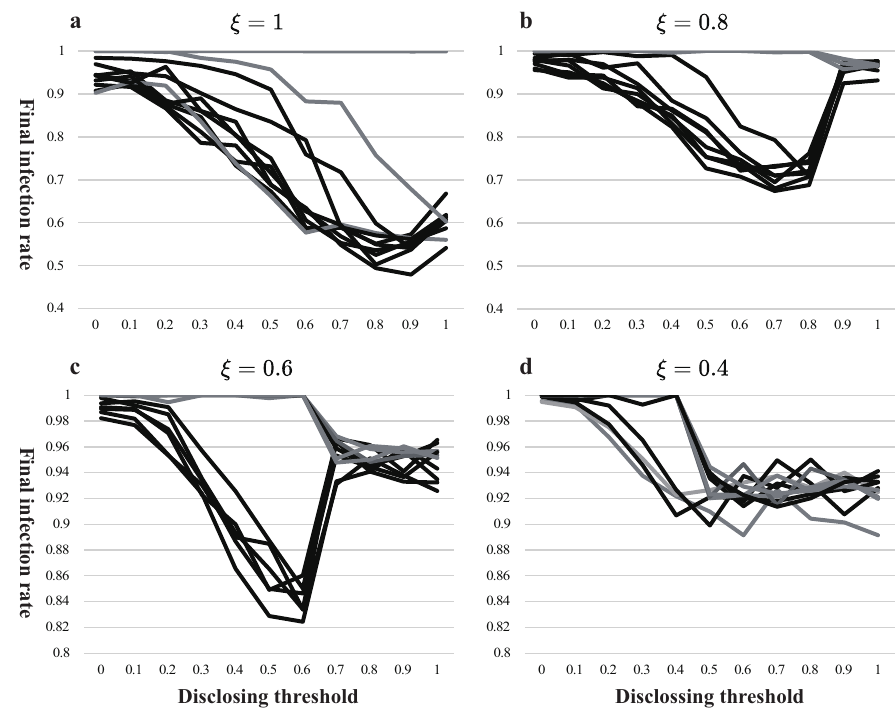
Figure 3. Distribution diagram of disclosing threshold. These four subfigures ( a – d ) correspond to initial information of 1, 0.8, 0.6, and 0.4, respectively, each one has 11 curves representing individual thresholds of all 11 values, which shows the optimal disclosing thresholds under all 44 different external constraints. The horizontal axis is all possible values of disclosing thresholds, the vertical axis is the infection rate of the whole